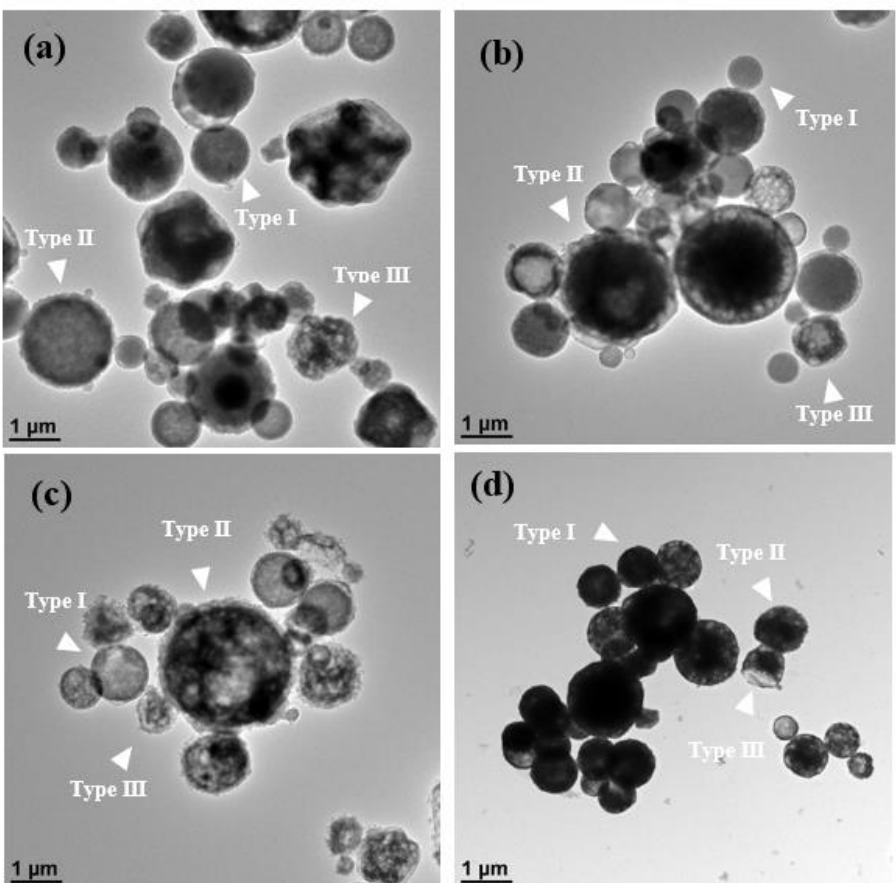
Figure 4. TEM images of Mg 2 SiO 4 -calcined powders at ( a ) 850, ( b ) 900, ( c ) 950, and ( d ) 1000 °C. The various morphological types are highlighted with triangles.